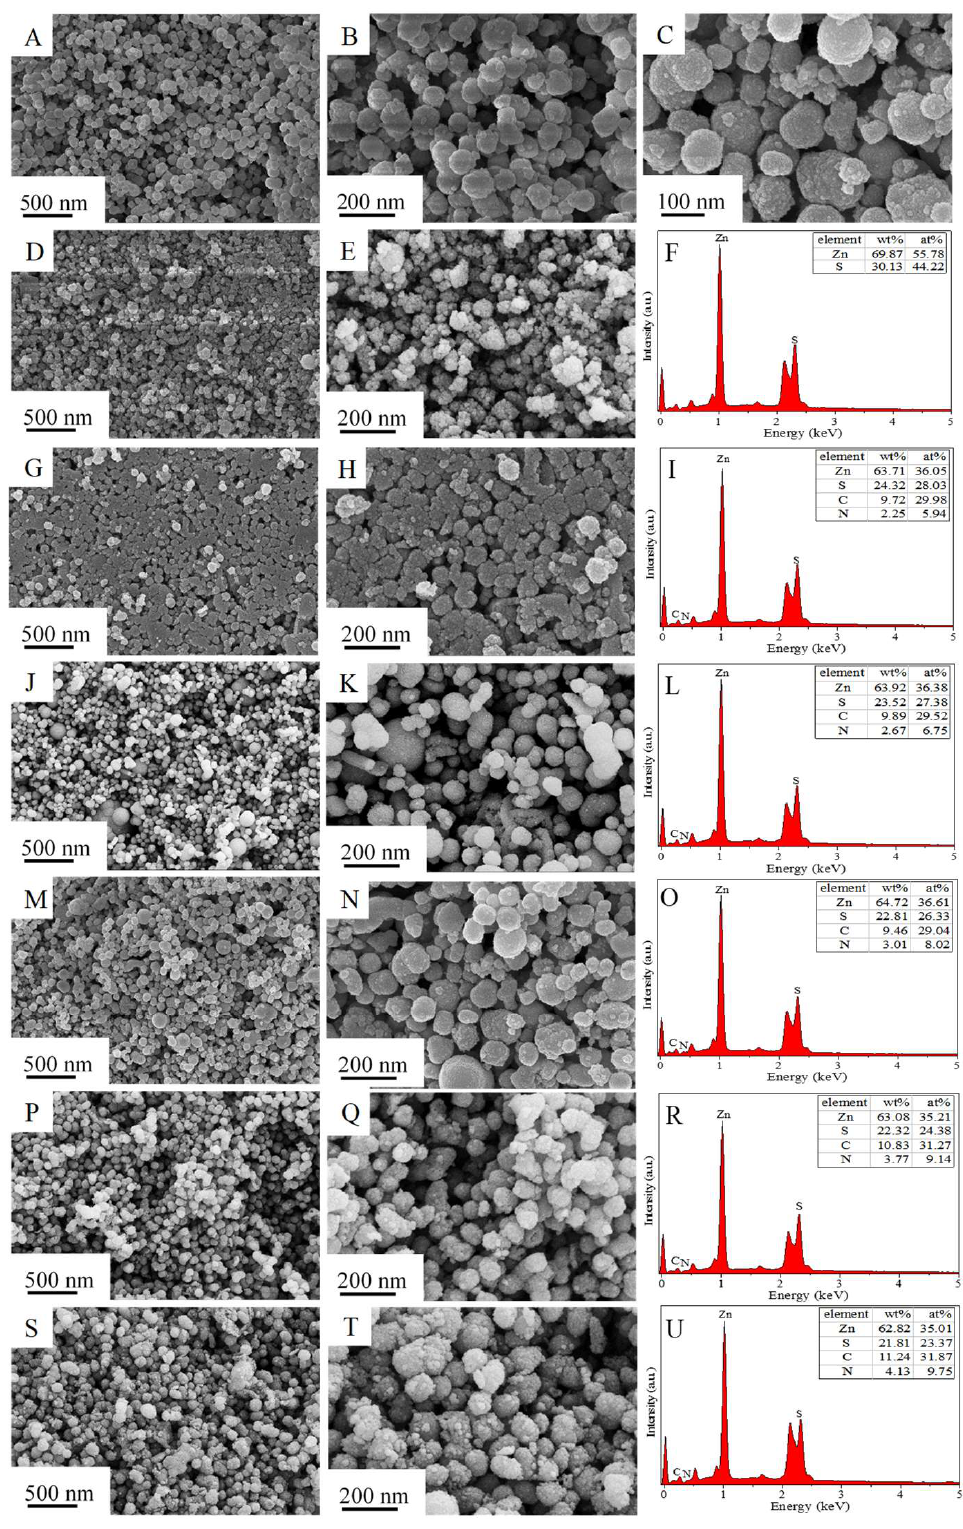
Figure 2. Scanning electron microscopy (SEM) images and the corresponding energy dispersive X-ray analysis(EDX) patterns of ZnS ( A – C ), calcined ZnS ( D – F ), ZnS@N-C-1 ( G – I ), ZnS@N-C-2 ( J – L ), ZnS@N-C-3 ( M – O ), ZnS@N-C-4 ( P – R ), and ZnS@N-C-5 ( S – U